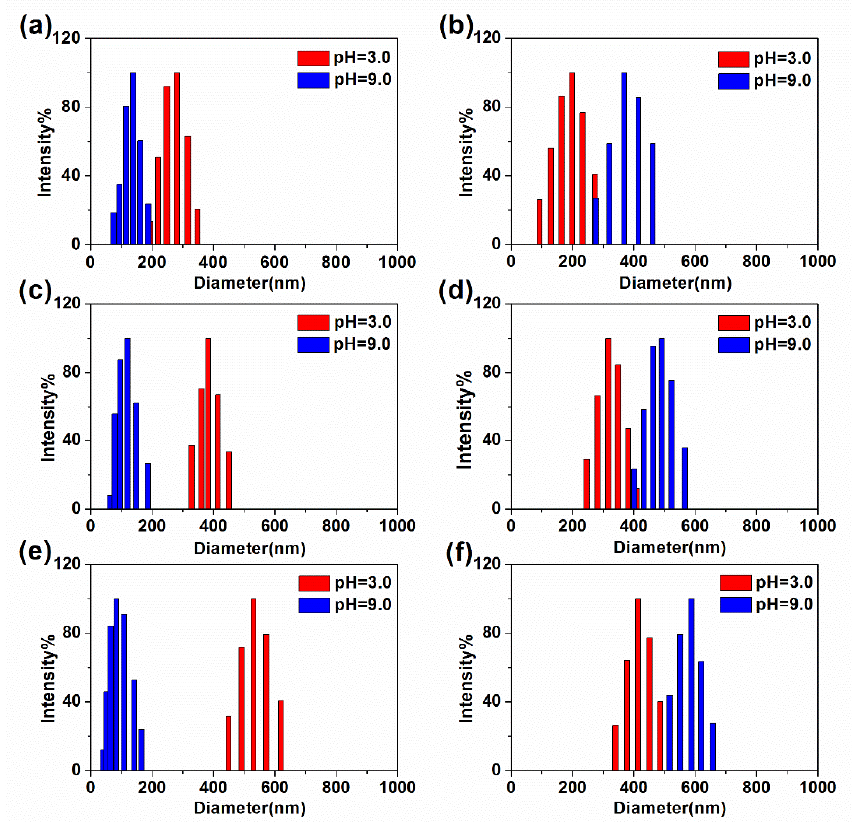
Figure 3. The apparent D h distributions of 1.0 mg mL − 1 aqueous solutions of 4-arm star-PAA 2 - b - PDMAEMA 4 ( a ), 4-arm star-PDMAEMA 4 - b -PAA 2 ( b ), 8-arm star-PAA 2 - b -PDMAEMA 4 ( c ), 8-arm star-PDMAEMA 4 - b -PAA 2 ( d ), 12-arm star-PAA 2 - b -PDMAEMA 4 ( e ), 12-arm star-PDMAEMA 4 - b - PAA 2 ( f ).